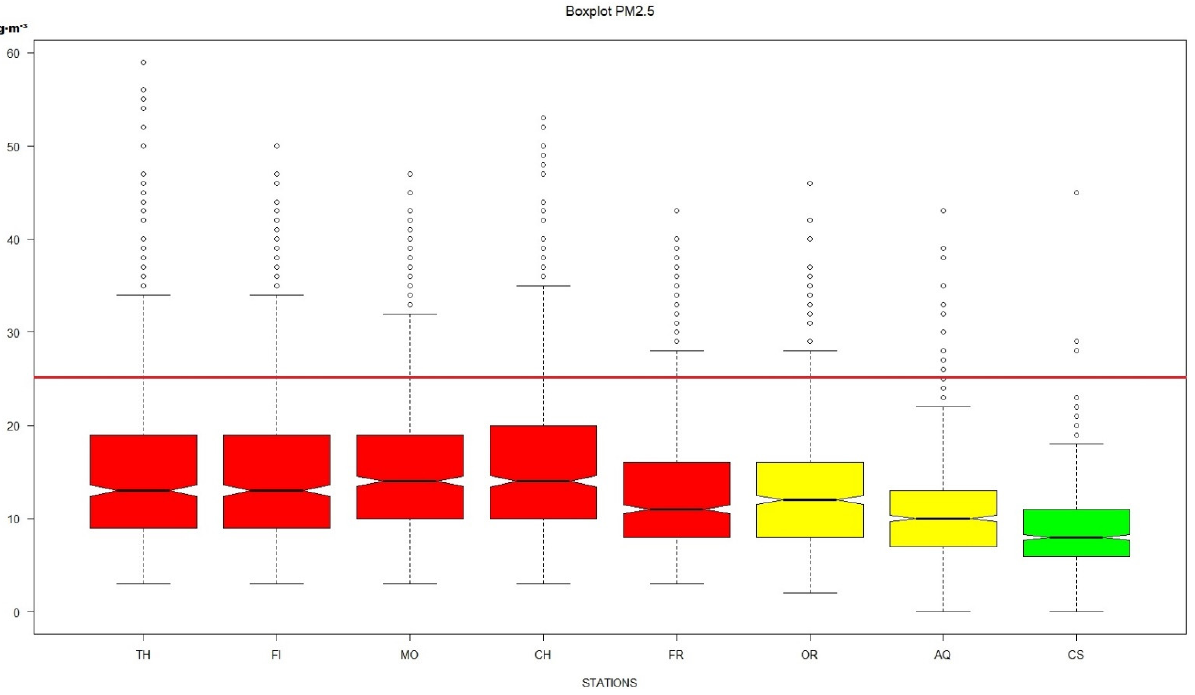
Figure 4. Boxplot of PM2.5 distributions in µ g · m − 3 , 2017–2018: in red are the stations in AGG, in yellow are those in MAXP, and in green is the station in MINP. The red line indicates the annual EU limit for